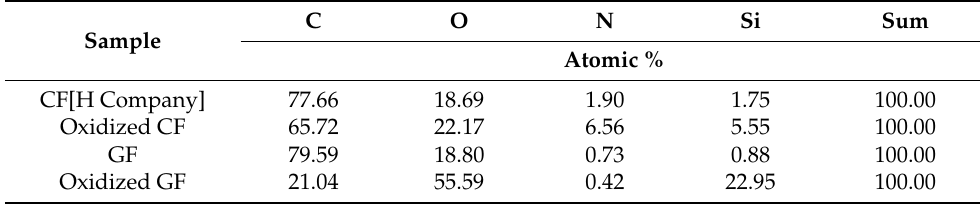
Table 7. Functional amounts of fibers and oxidized